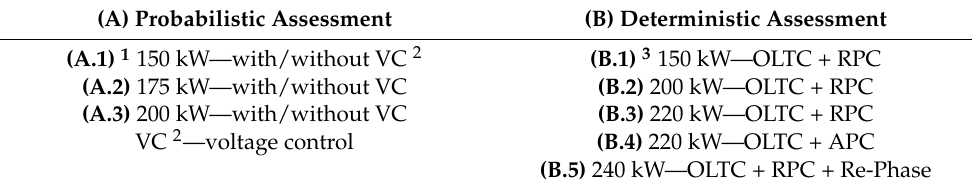
Table 1. Test cases studied.